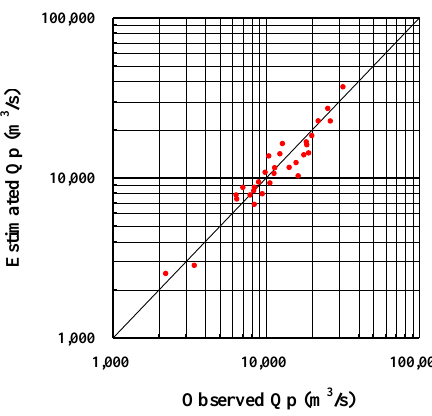
Figure 13. Annual Maximum Series of Observed and Estimated Peak Inflow at the Paldang Dam. The daily flow peaks simulated by SWAT were converted to hourly flow peaks using Sangal’s analysis (Figure